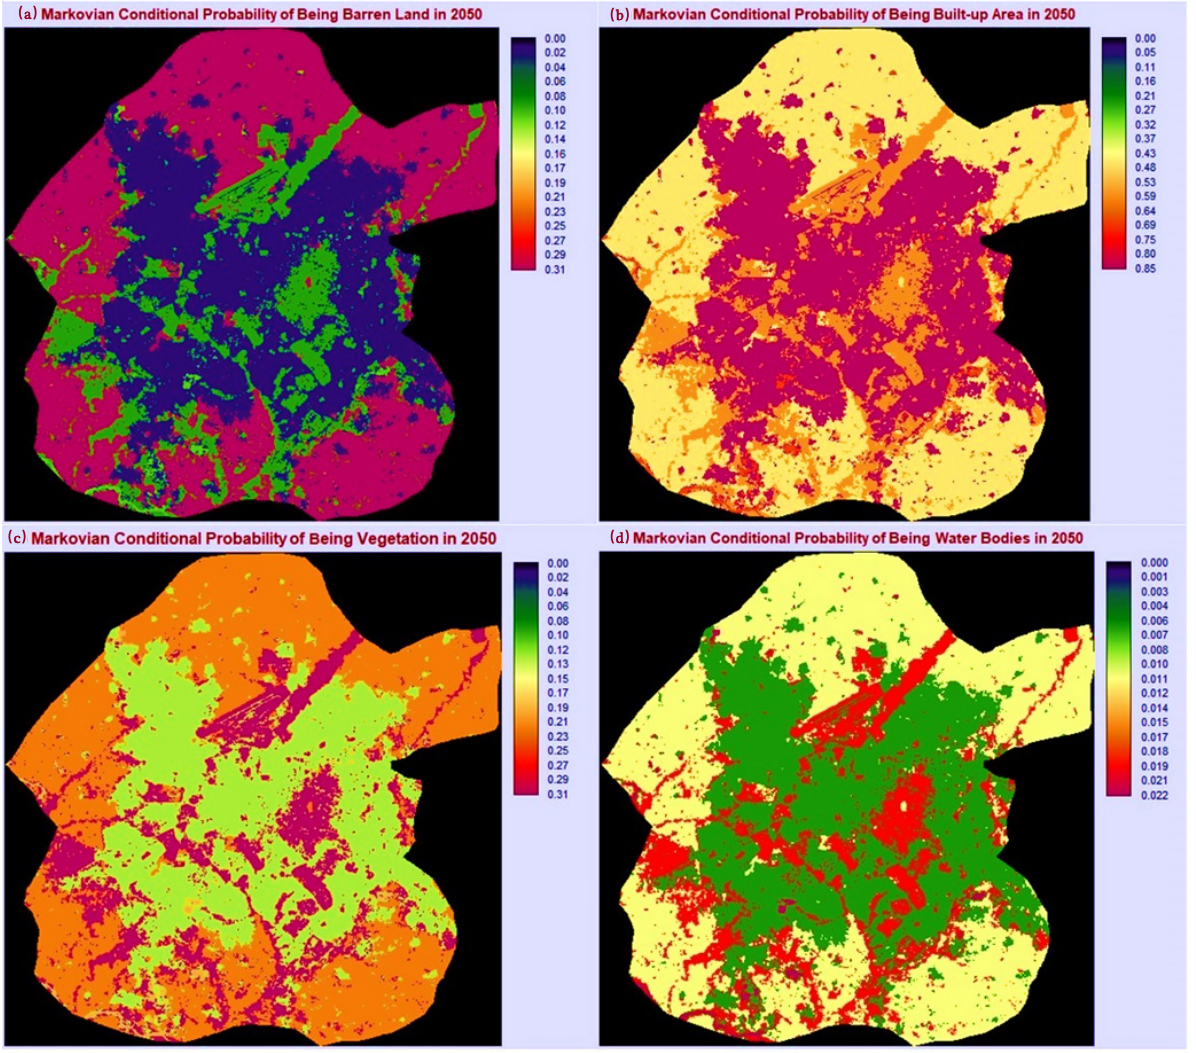
Figure 7. Markovian conditional probabilities for the predicted, ( a ) Barren Land, ( b ) Built-up Areas, ( c ) Vegetation, and ( d ) Waterbodies in